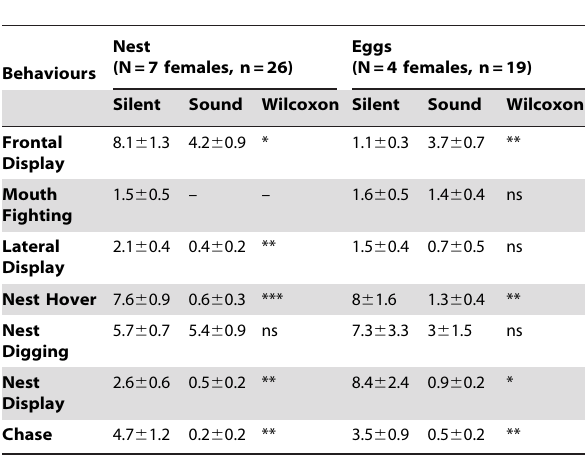
Table 8. Mean ( 6 SE) of the occurrence of a behaviour appearing on a 15 min recording, for Oreochromis niloticus females.